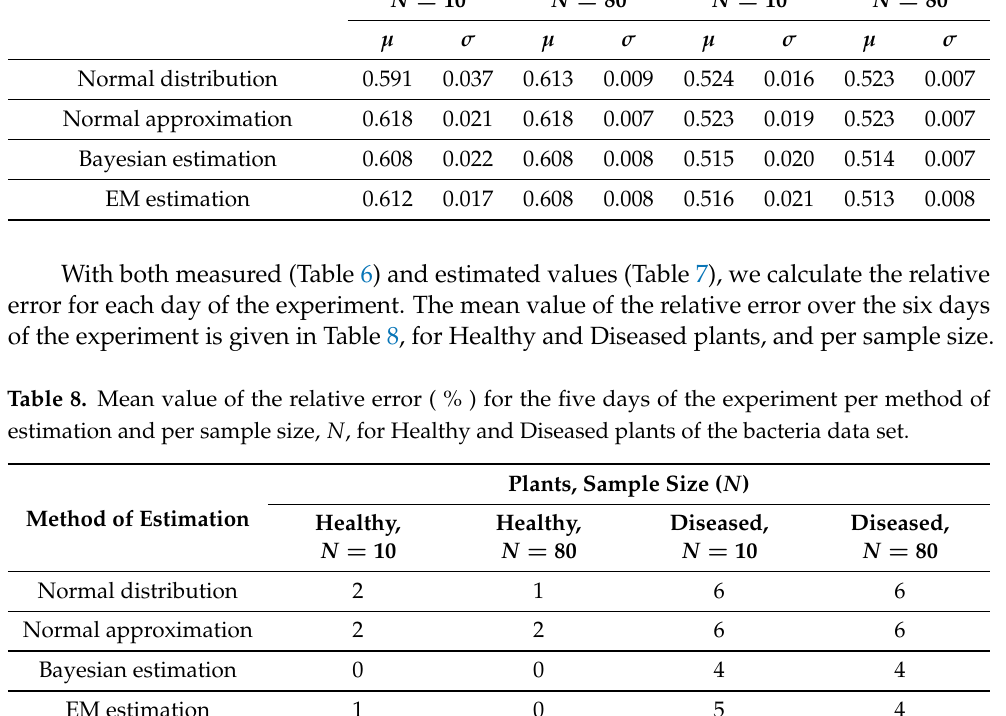
Table 7. The mean value ( µ ) and the associated standard deviation ( σ ) of the second-order fractional moment of the Monte Carlo simulation for 10 and 80 sample sizes, with the first day of the experiment as a reference value, with the assumptions of Gaussian probability density function and the Gaussian approximation proposed in [34] and with the two non-Gaussian estimators, Bayesian and EM. Plants, Sample Size ( N ) Healthy, Healthy, Diseased, Diseased, Method of Estimation N = 10 N = 80 N = 10 N = 80 µ σ µ σ µ σ µ σ Normal distribution 0.591 0.037 0.613 0.009 0.524 0.016 0.523 0.007 Normal approximation 0.618 0.021 0.618 0.007 0.523 0.019 0.523 0.007 Bayesian estimation 0.608 0.022 0.608 0.008 0.515 0.020 0.514 0.007 EM estimation 0.612 0.017 0.608 0.008 0.516 0.021 0.513 0.008